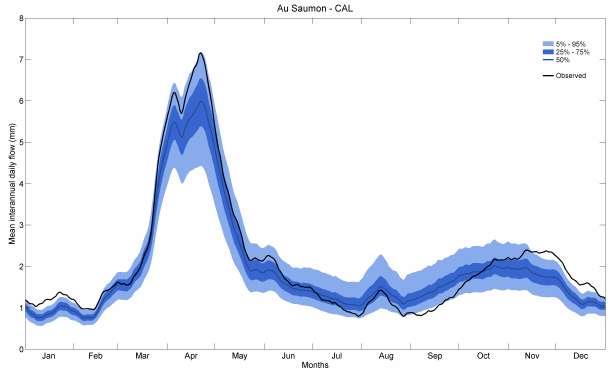
Figure 4. Cumulative uncertainties for the observed period simula- tion. The black line is the observed flow, the blue line depicts the median flow simulation, and the pale and dark blue envelopes, the distribution of the streamflow ensemble (5 to 95% and 25 to 75%,